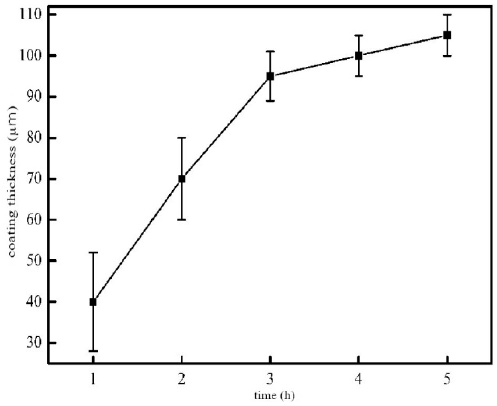
Figure 2. Aluminide layer thickness changing with aluminizing time.